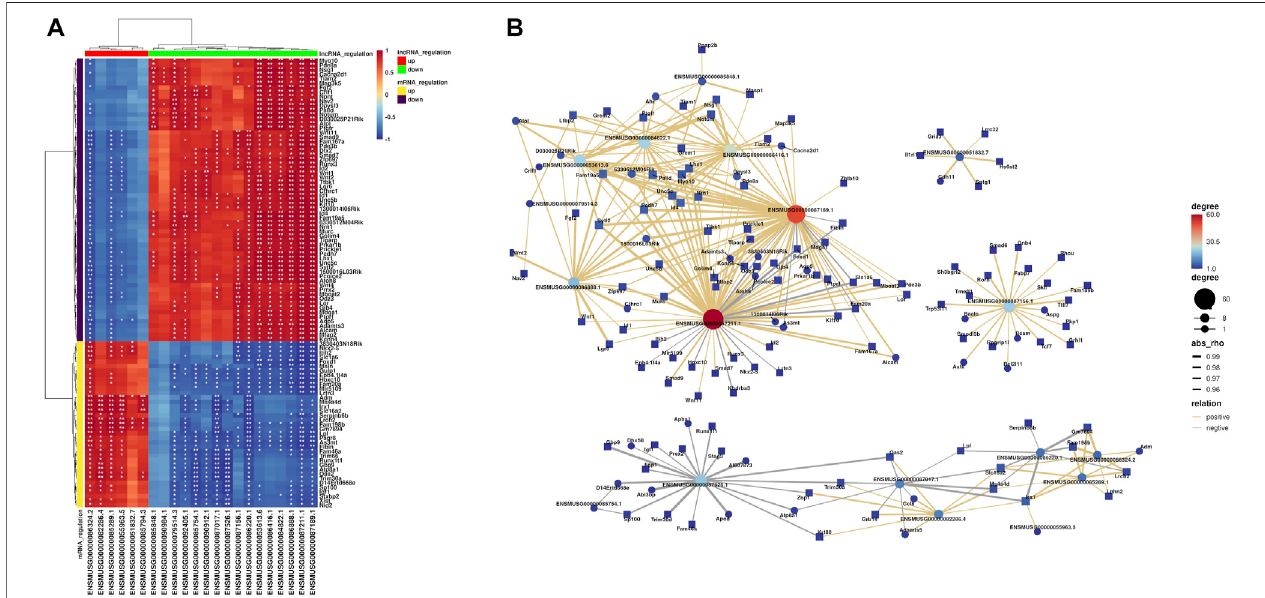
FIGURE6| Results ofco-expressionnetworksbetweenmRNAsandlncRNAs. (A) HeatmapsareusedtodescribetherelationshipbetweenlncRNAsandmRNAs (different colors of lncRNA or mRNA regulation). The differences that are statistically signi fi cant are denoted by asterisks, with single asterisks representing p < 0.05 and two asterisks representing p < 0.01. (B) Hub co-expression network between lncRNAs and mRNAs. The yellow line represents the positive regulation, the gray line represents the negative regulation, and the thickness of the line represents the relative strength. In addition, the size and color depth of the points represent the number of related